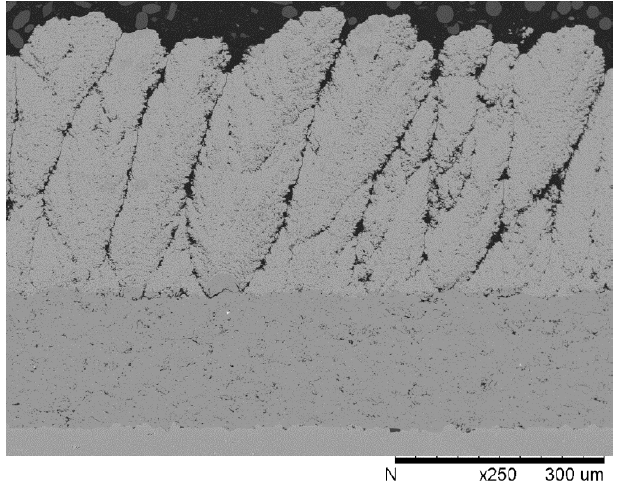
Figure 6. T5 coating, 500 nm suspension.